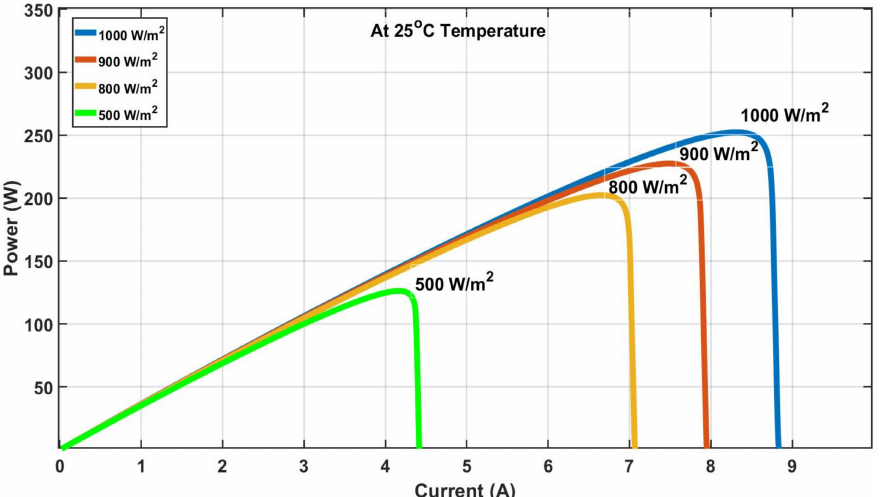
Figure 10. P-I curves with different irradiances at 25 ◦